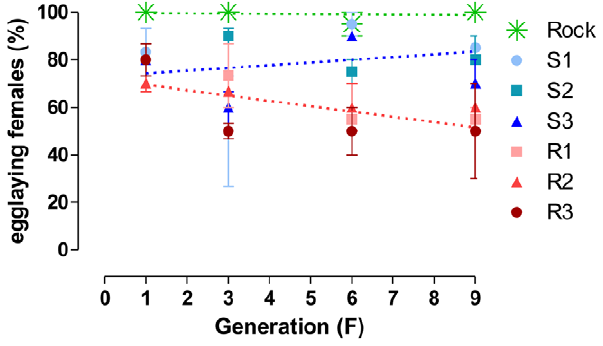
Figure 3. Amount of egglaying females – selected lineages. Mean rate of Aedes aegypti egglaying females during deltamethrin selection in the laboratory. All blood-fed females were considered. Standard error is also indicated. Lines indicate linear regression analysis for Rock ( b = 2 0.0996, r2=0.0332, p . 0.05), and pooled S ( b =1.136, r2=0.0691, p . 0.05) and R ( b = 2 2.228, r2=0.4114, p , 0.05) lineages.